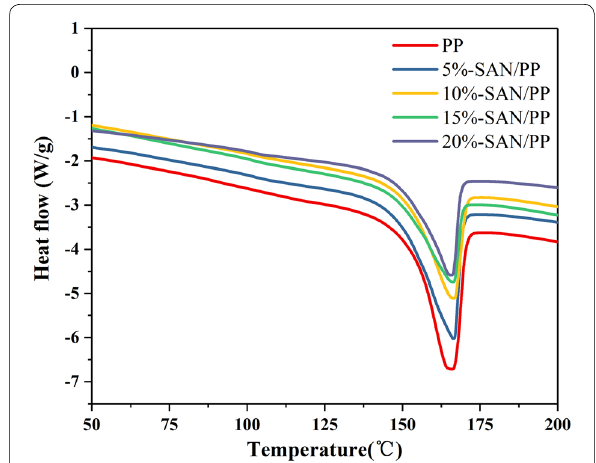
Fig. 3 DSC patterns of PP and SAN/PP blends